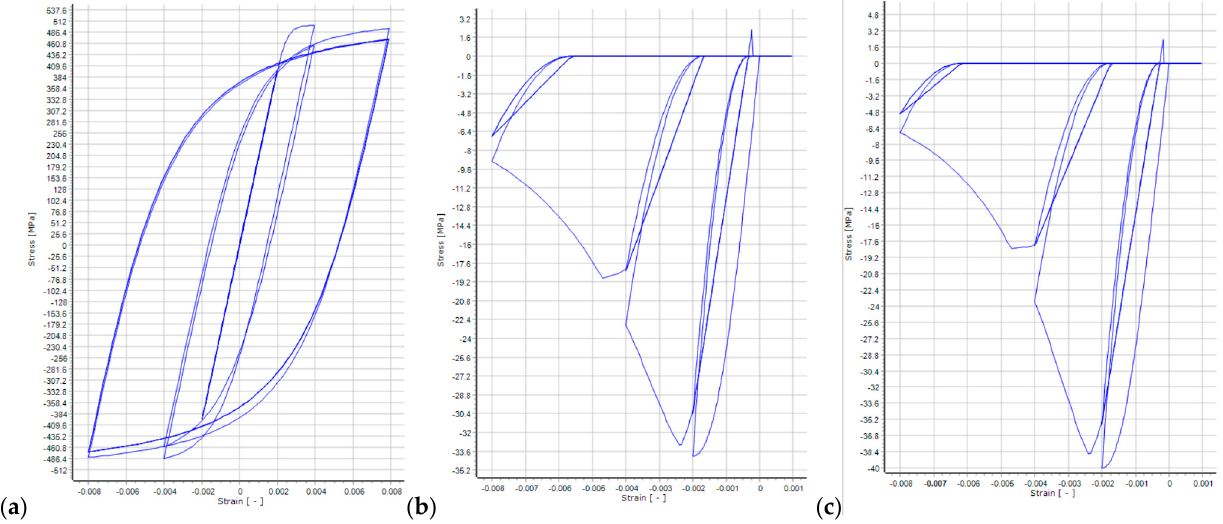
Figure 6. Constitutive curves of ( a ) reinforcement steel, ( b ) G20, and ( c ) G25 concrete as taken from SeismoStruct . Table 3. Eigenfrequencies and effective masses (first four modes). n.